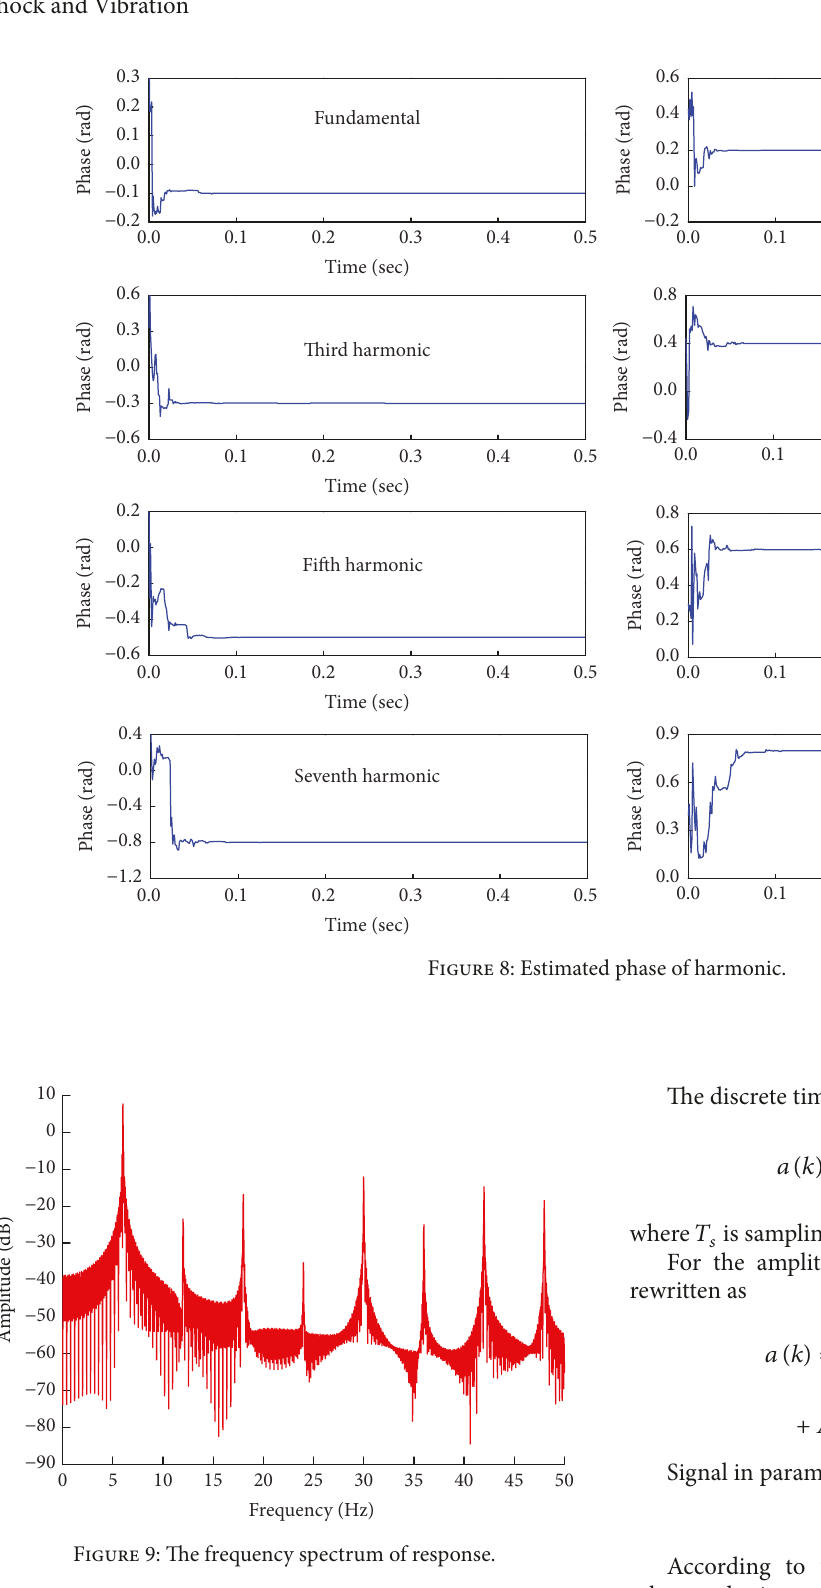
frequency of the 𝑛 th harmonic, respectively. The angular frequency can be expressed as 𝜔 𝑛 = 2𝜋𝑛𝑓 1 , where 𝑓 1 is the fundamental